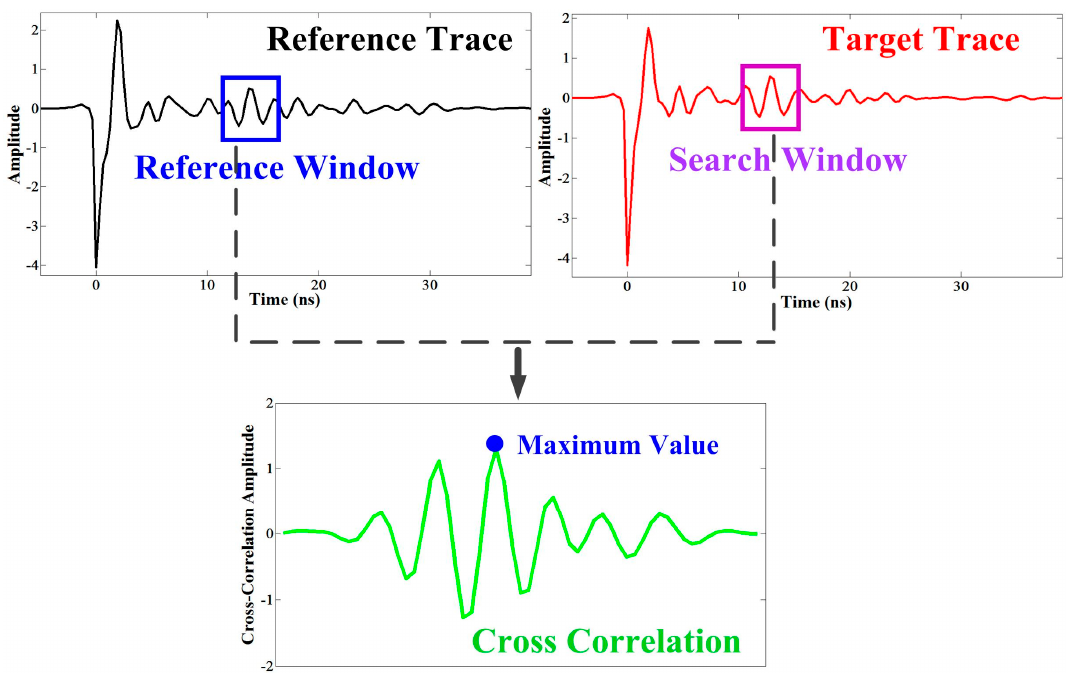
Figure 5. The schematic for step (2) of the modified trace correlation method. The black signal and red signal indicate reference trace and target trace respectively. The blue and purple rectangles indicate reference window and search window respectively. The search point is the center of both reference window and search window. The green line indicates the cross correlation between signals within reference window and search window. The blue point is maximum value of correlation.